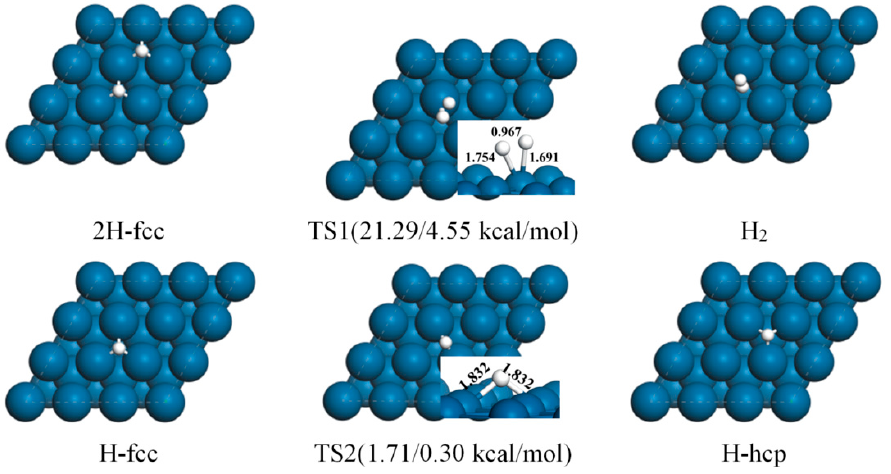
Figure 7. Reactants, transition states and products of H 2 desorption and H(a) diffusion on Pt(111).